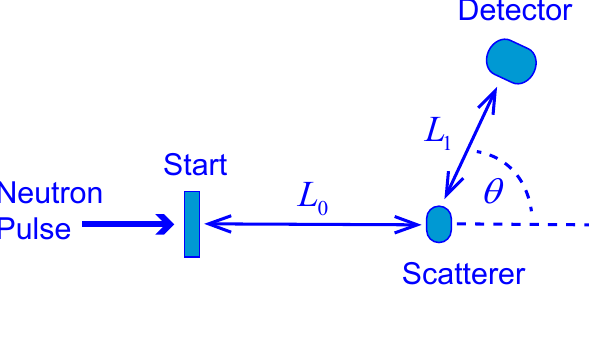
Figure 1: Schematic of a time-of-flight scattering